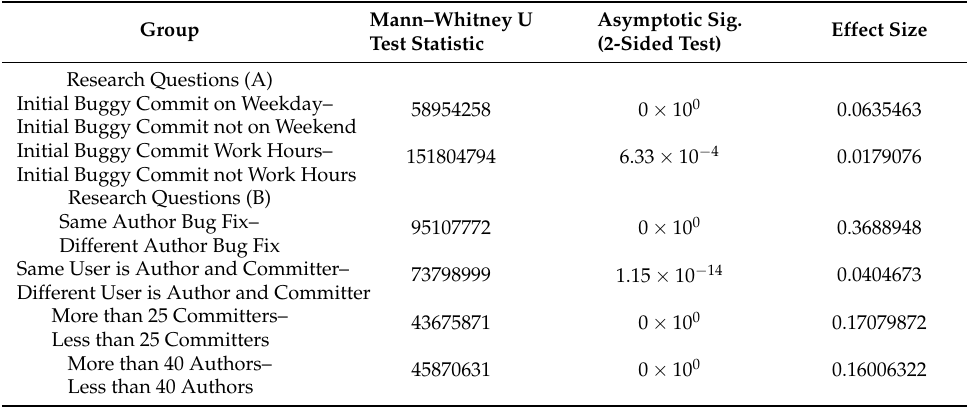
Table 2. Mann–Whitney U test results per research